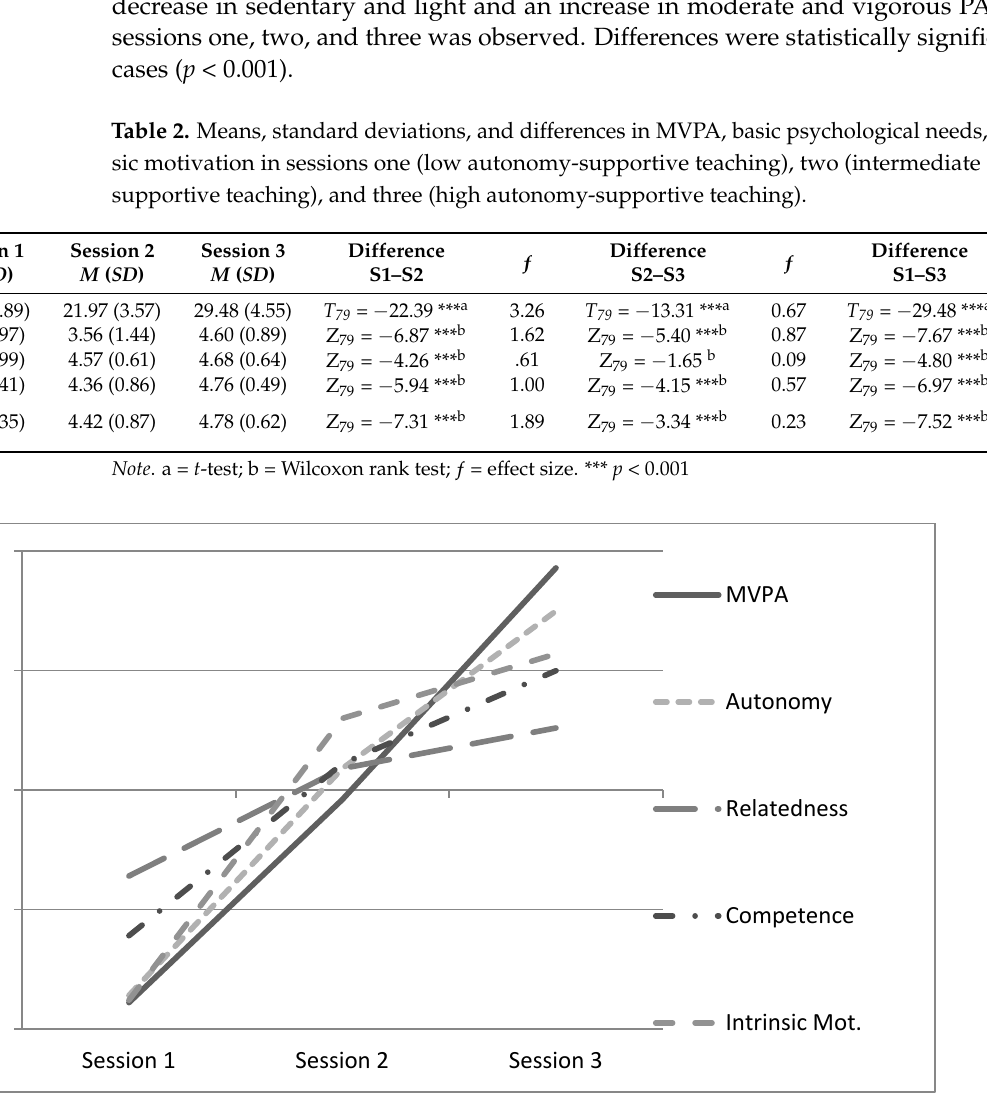
Figure 2. MVPA, basic psychological needs, and intrinsic motivation in sessions one, two, and three. Table 3. Means, standard deviations, and percentages of sedentary, light, moderate, and vigorous physical activity in sessions one (low autonomy-supportive teaching), two (intermediate autonomy- supportive teaching), and three (high autonomy-supportive